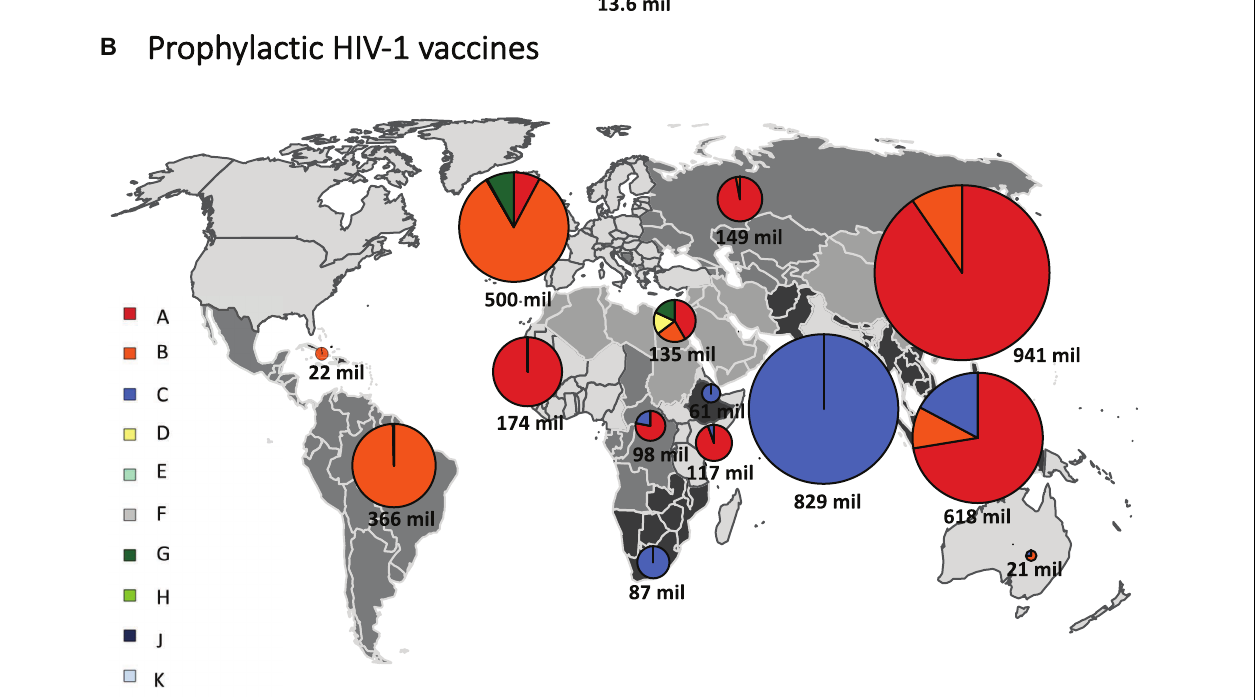
FIGURE 4 | Regional estimates of the number of doses of subtype-specific therapeutic and prophylactic HIV-1 vaccines. Regional estimates for therapeutic (A) and prophylactic (B) HIV-1 vaccines based on the most common subtype, based on the full-length sequence, in each country. We grouped all countries into 14 regions, as previously described (Hemelaar et al., 2019). Individual regions are shaded differently on the world map. The estimates for vaccines based on each HIV-1 subtype are shown in pie charts superimposed onto the regions. The sizes of the pie charts (surface area) correspond to the relative number of vaccine doses for each region and the total number of vaccine doses is shown below each pie chart. mil, million. Data underlying this figure is displayed in Supplementary Material , p. 11.